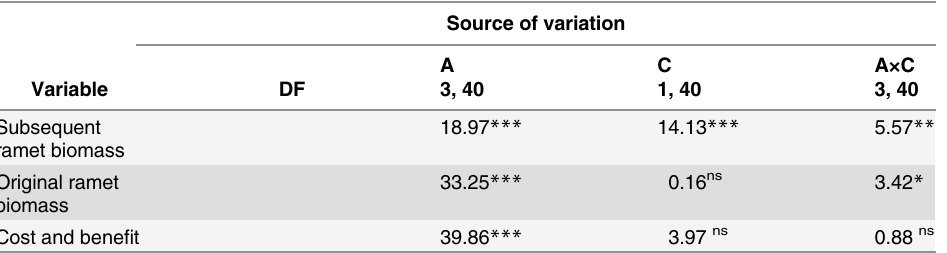
Table 3. Analysis of variance for the effects of alkalinity stress (A) and rhizome connection (C) on the biomass of original and subsequent ramets and cost-bene fi t